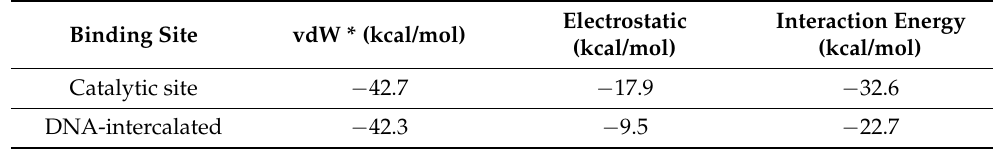
Table 1. Results of the MM/GBSA analyses of the MD trajectories of the hTop1-DNA complex with the drug.